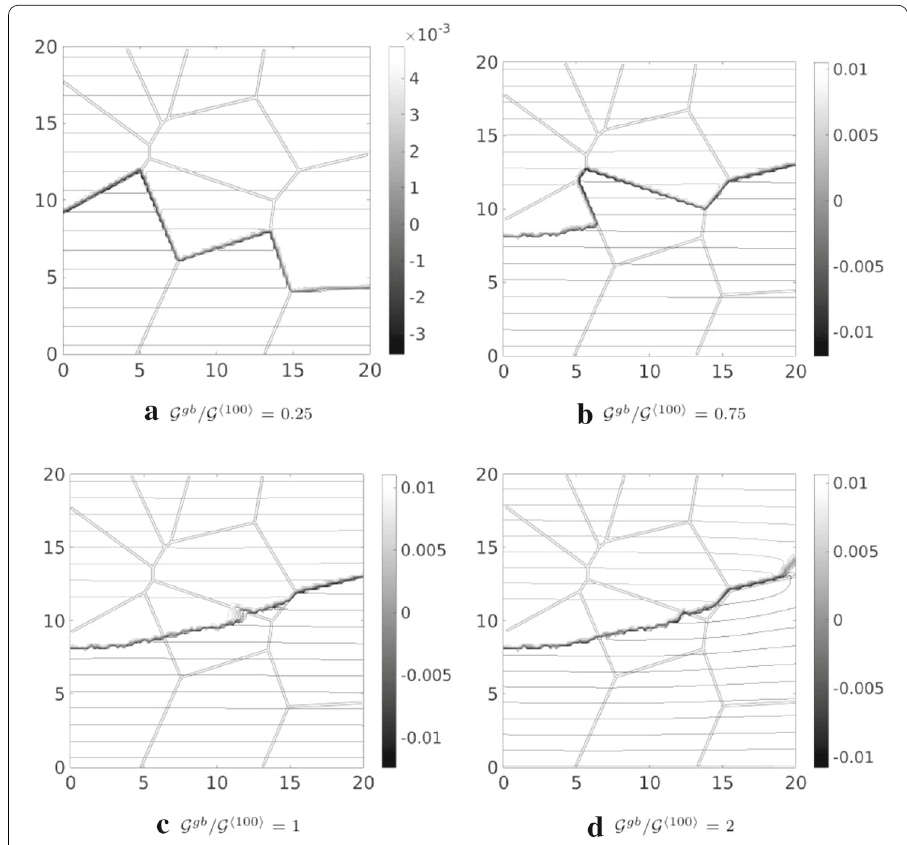
Fig. 11 Contour plots of inelastic displacement field, illustrating the crack path for different values of G gb / G (cid:8) 100 (cid:9) (from [51]) granular fracture developed from the notch and it competed with intergranular debonding (Fig. 11b). For much higher high values of G gb / G (cid:8) 100 (cid:9) greater than 1, failure was mostly dominated by transgranular fracture (Fig. 11c,